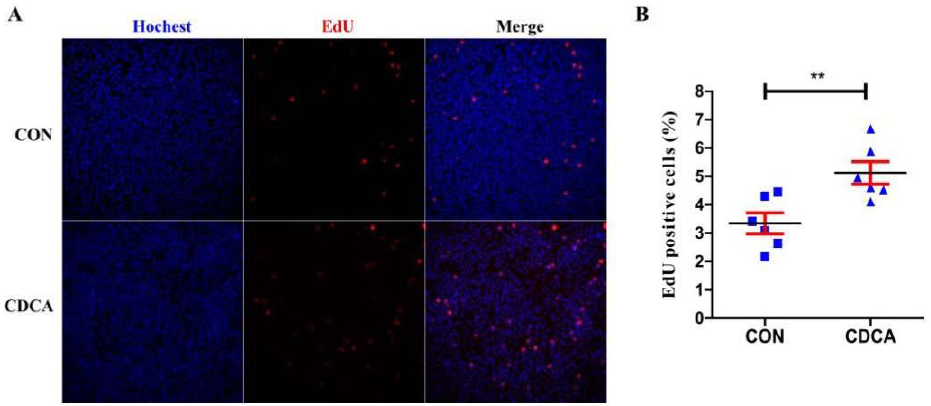
Figure 2. Effects of CDCA on the proliferation of IPEC-J2 cells ( n = 6). The representative EdU staining plots of IPEC-J2 cells ( A ) and the proportion of EdU-positive cells ( B ). Cells were seeded at a density of 1.5 × 10 5 /well in 96-well plates. Values are presented as mean ± SEM. ** p < 0.01 compared with the CON